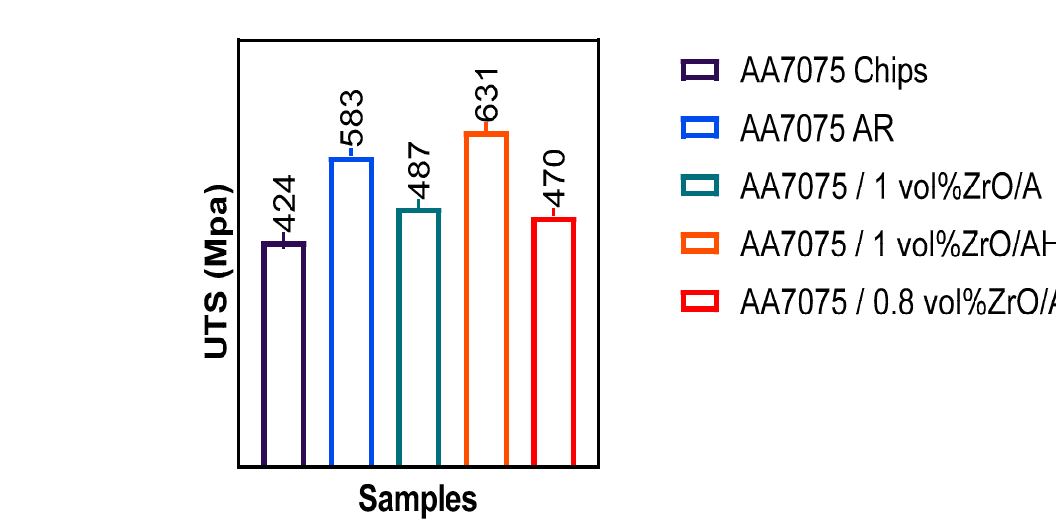
Figure 5. UTS of various composite samples.